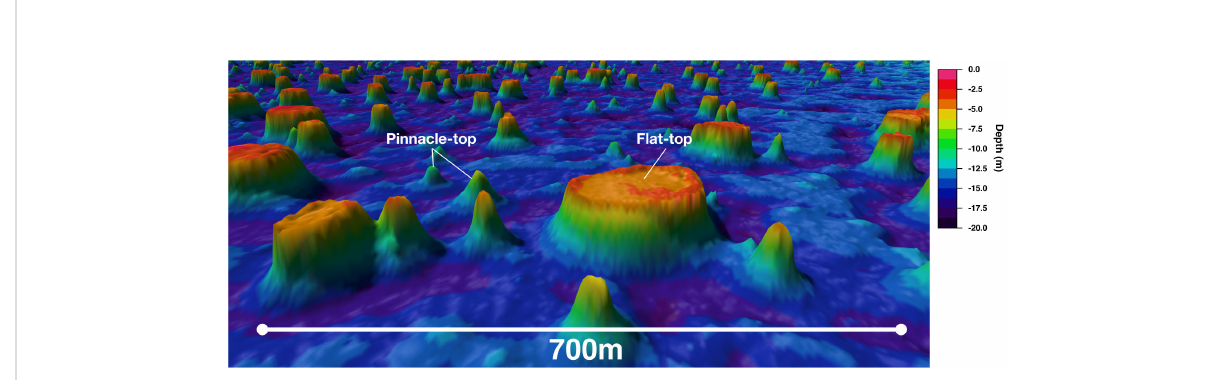
FIGURE 3 Bathymetric LiDAR image of Dongsha Atoll. Oblique view revealing fl at-top and pinnacle-top patch reefs in the Dongsha Atoll lagoon. Vertical relief is not proportional in scale to the planar surface, as indicated by colors. The maximum depth of the Dongsha Atoll lagoon is approximately − 20 m.